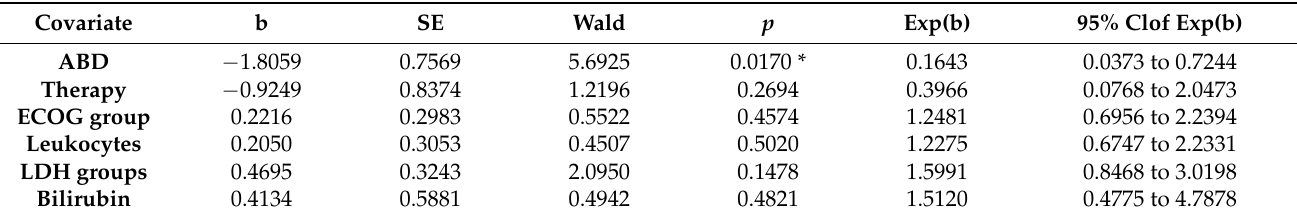
Table 3. Multivariate analysis of LDH, leukocytes, bilirubin, ECOG and